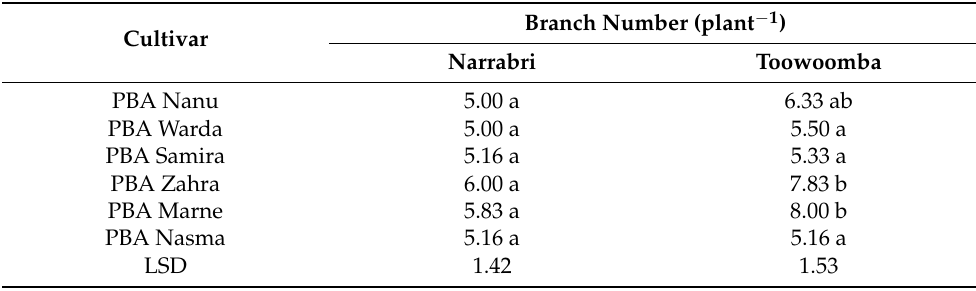
Table 7. Branch number (plant − 1 ) of different faba bean cultivars grown in Narrabri and Toowoomba. Means with a different letter are significantly different at p value ( α =